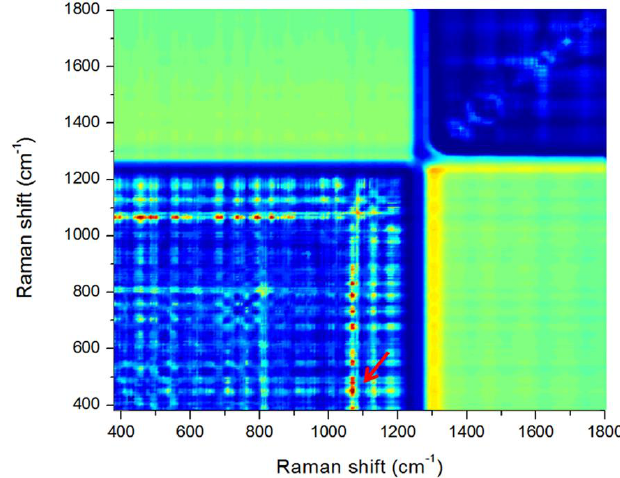
Figure 8. F -values for wavenumber pairs used for determining the optimal Raman shift band-ratio between bacteria-infected and healthy watermelon seeds.